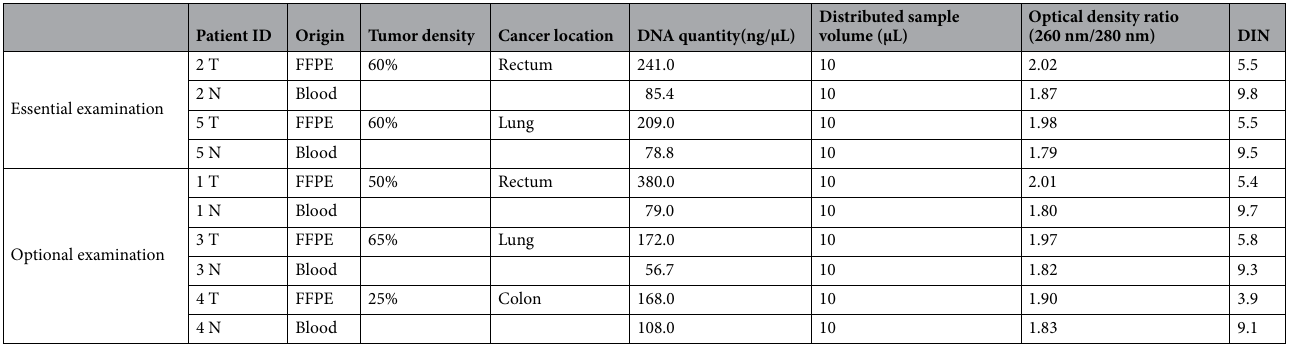
Table 3. Properties of the patient